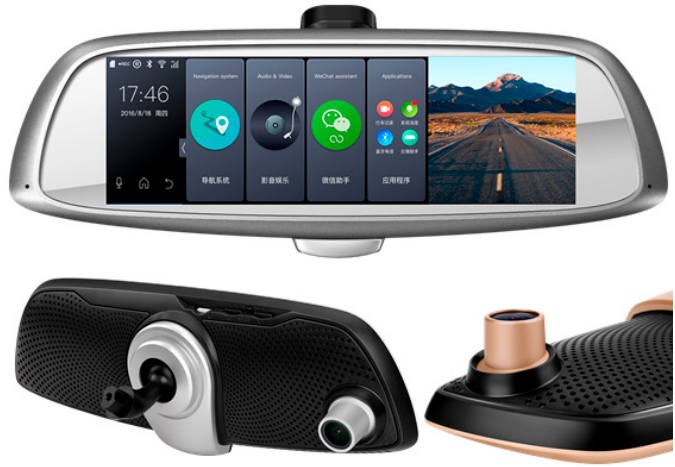
Figure 2. Appearance photo of our UBI terminal based on high precision BDS/GPS positioning.